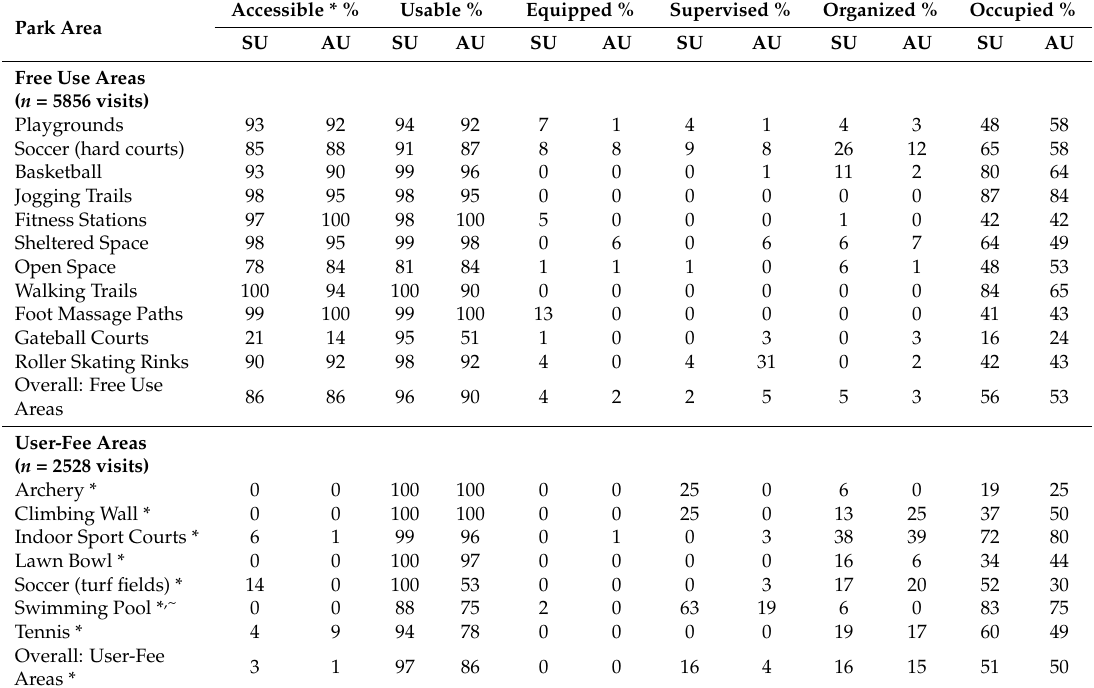
Table 6. Proportion of observations in park areas during which specific characteristics were observed during summer (SU) and autumn (AU) (total area visits = 8384).